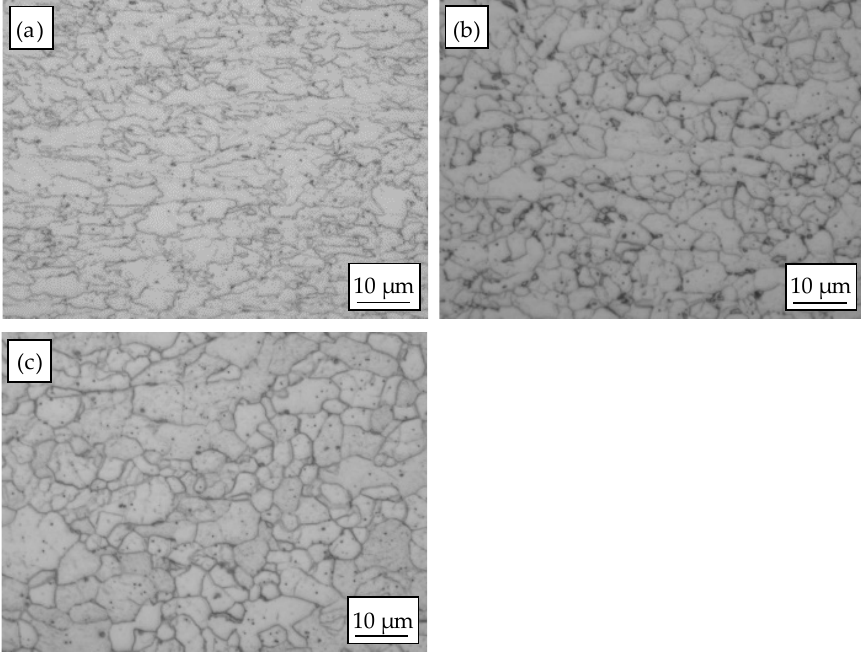
Figure 1. OM microstructures of different samples: ( a ) HR sample; ( b ) EF1 sample; ( c ) EF2 sample. The typical morphology photos of precipitates in the HR, EF1, and EF2 samples are presented in Figure 2. It can be observed that the precipitates (small black particles, as indicated by the black arrows) are uniformly distributed in the ferrite grains (as indicated by the red arrows) in these three samples. The average sizes of the precipitates in the HR, EF1, and EF2 samples are measured using Image Pro Plus software to be 7.5 nm, 12.5 nm, and 13.5 nm, respectively. The effective sizes of precipitates were determined by their area. It can be found that the average of the precipitates gradually increases after enamel firing.